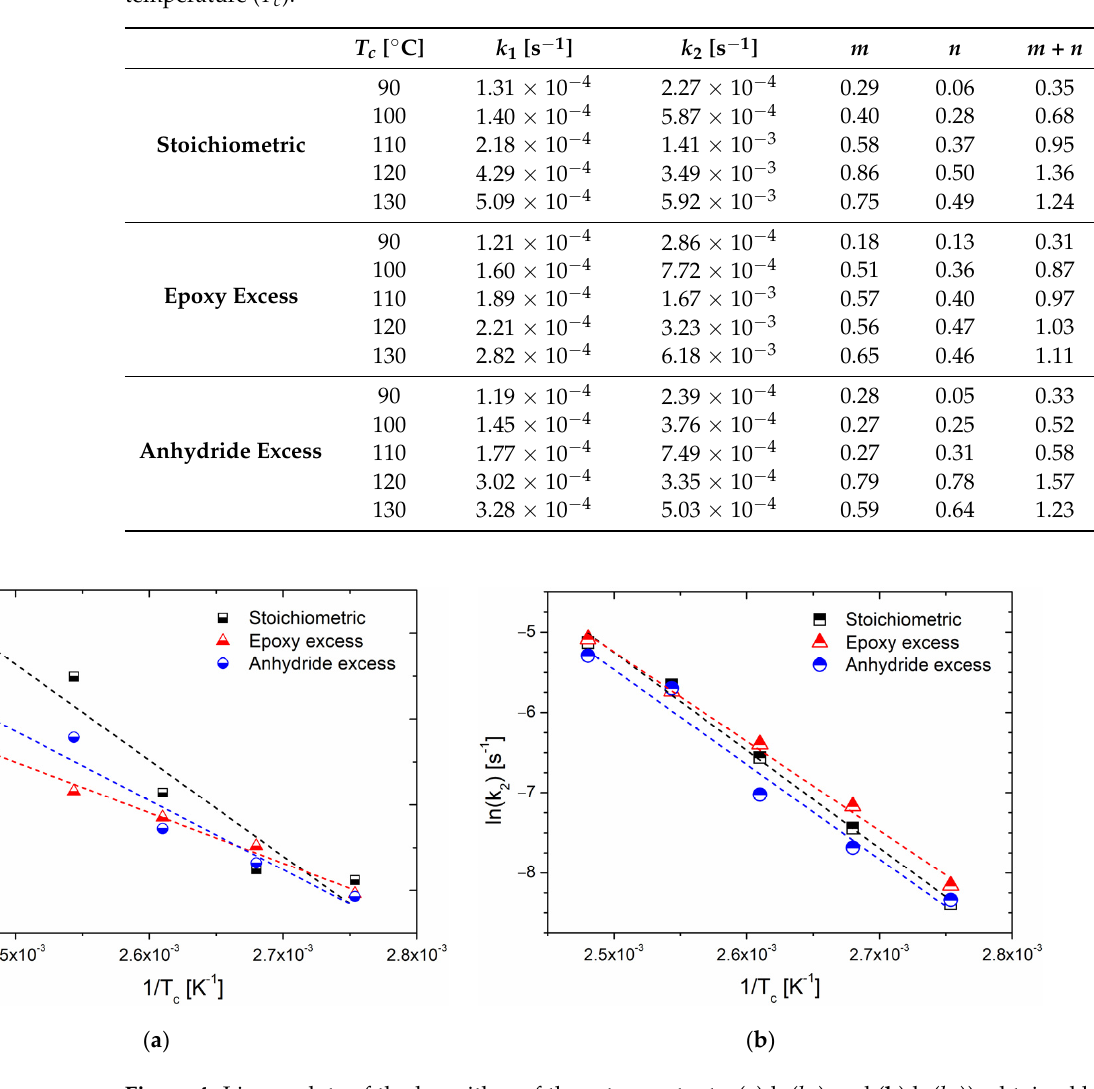
Table 4. Kinetic parameters obtained by least square fitting of the curing degree rate d α /dt versus α by the Kamal method for systems with different epoxy/anhydride ratios as function of curing temperature ( T c ).